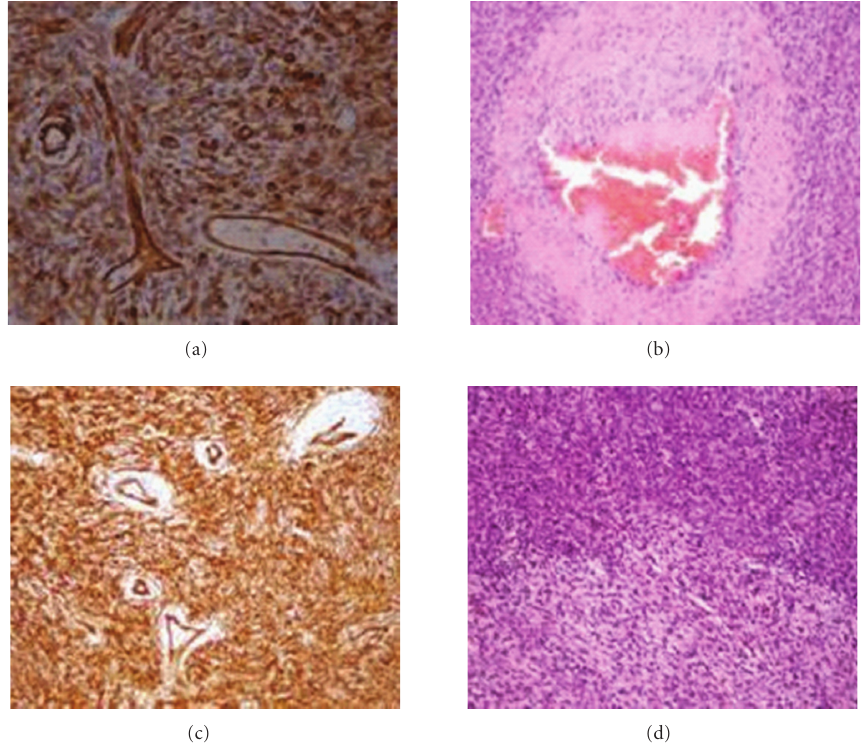
Figure 5: (a) Malignant solitary fibrous tumour demonstrating uniform immunoreactivity for CD34 (CD34 x400) with hemangiopericytoma-like morphology. (b) A hyalinized vessel with thrombus in it is evident (HE x200), as well as (c) hyalinized staghorn vessels of tumour, that are centered (CD34 x200). (d) Areas of hypo- and hypercellularity (HE x200) are